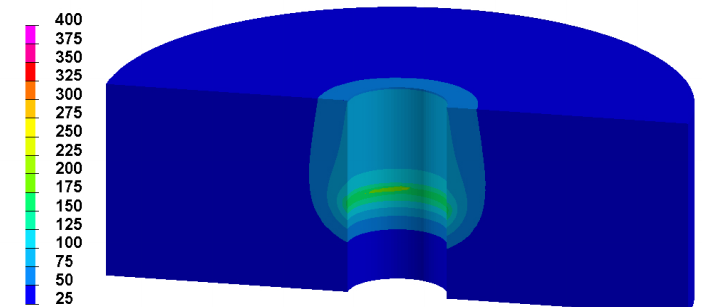
Figure 15. Mesh of the 3D thermo-elasto-plastic modeling.